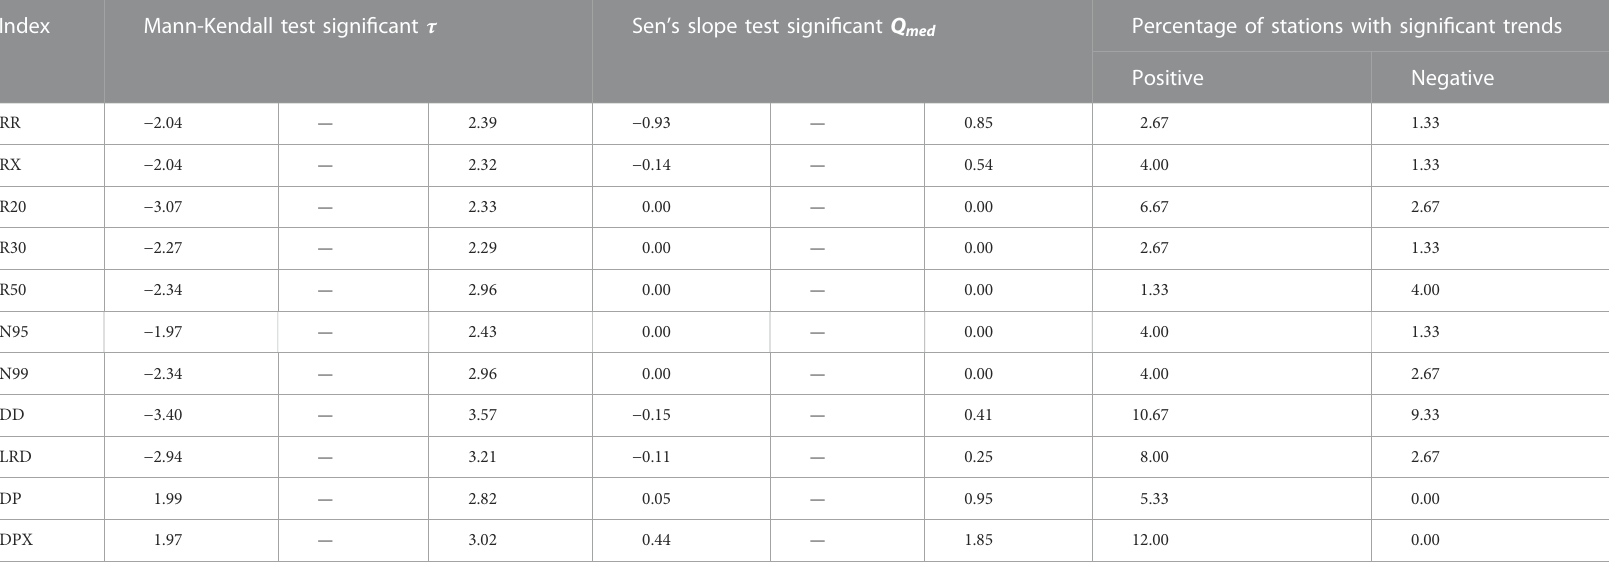
TABLE 4 Mann-Kendall ( τ ) and Sen ’ s slope estimator ( Q med ) tests results at the 5% signi fi cant level and the percentage of stations with signi fi cant trends for the precipitation indices in the dry season from 1974 to